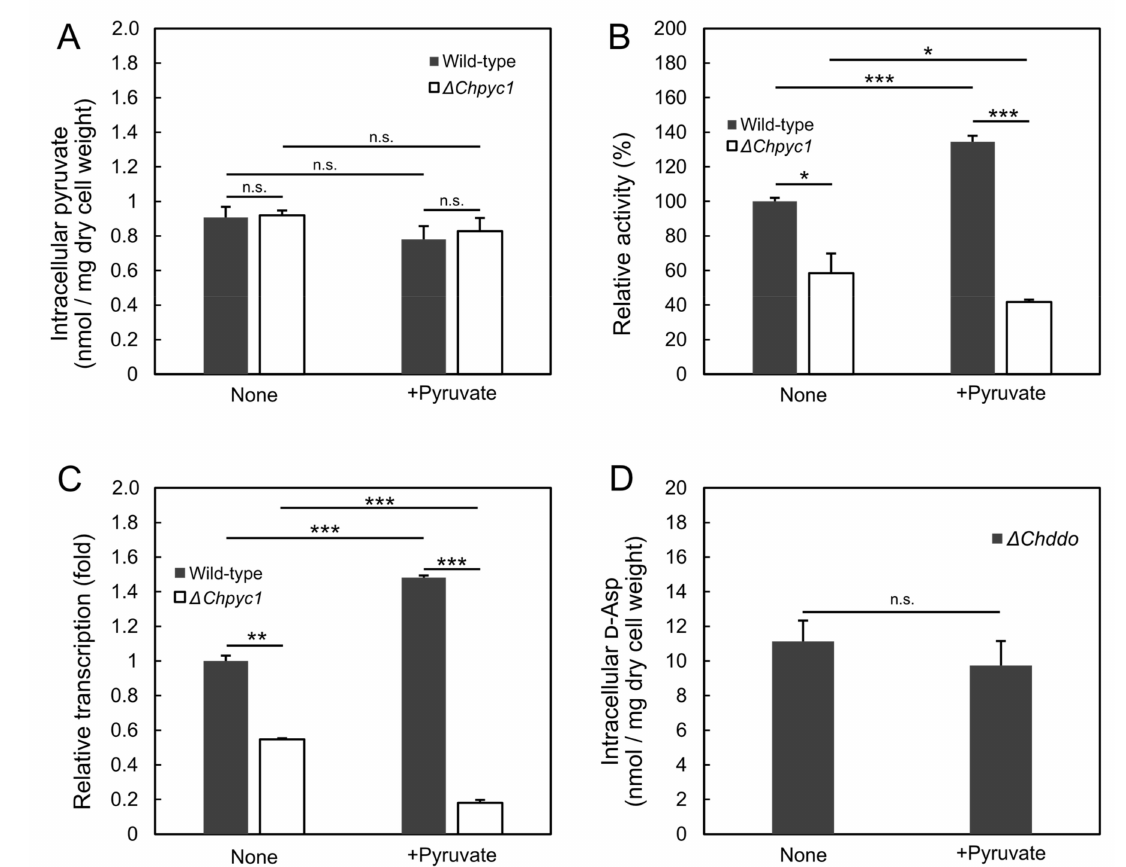
Figure 6. The analysis of the effect of pyruvate on ChDDO expression. ( A ) Intracellular pyruvate content in the crude extracts from the cells grown in YNB w/o AA and AS medium containing 60 mM D -Asp with 60 mM pyruvate (+Pyruvate) and without pyruvate (None). Pyruvate concentration in the crude extracts from the cells was determined by the enzymatic and fluorometric methods described by Zhu et al. [36]. Intracellular pyruvate content was calculated as pyruvate concentration per unit dry cell weight. ( B ) DDO activity. The activity in the crude extracts is expressed as a percentage of that of the wild-type strain at None. ( C ) The ChDDO gene transcription is expressed as a relative ratio of that of the wild-type strain at None. ( D ) D -Asp concentration in the crude extracts from the cells of ChDDO- gene disrupted strain [8] was determined by the HPLC method described by Kajitani et al. [35]. Intracellular D -Asp content was calculated as D -Asp concentration per unit dry cell weight. Statistical differences were ascertained by Welch’s t -test: n.s., no significant; * p < 5 × 10 − 2 ; ** p < 5 × 10 − 3 ; *** p < 5 × 10 − 4 . The values are the means of three independent experiments, and the error bars represent the standard